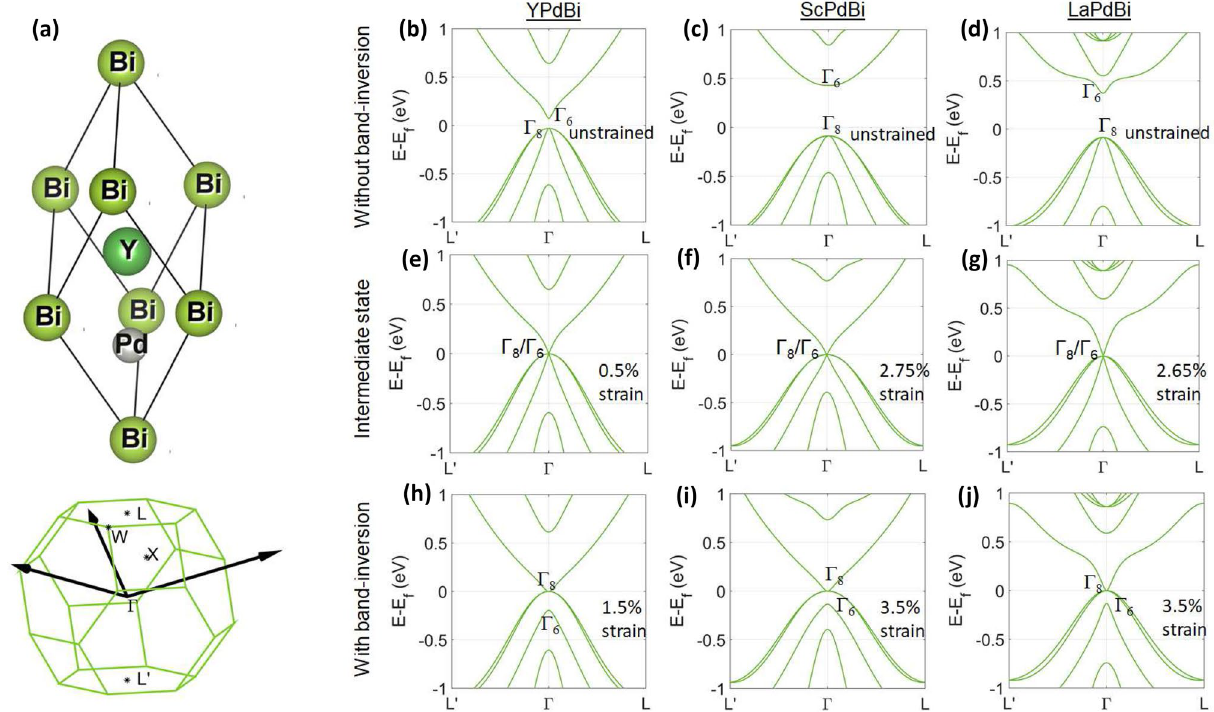
Figure 1. ( a ) Primitive unit cell of YPdBi and corresponding BZ with high-symmetry points and reciprocal vectors. All the materials considered in the present work has the same unit cell structure. ( b – j ) Band structure in YPdBi, ScPdBi and LaPdBi as a function of uniform tensile strain. Similar data for LuPdBi, YPtBi and LuPtBi under compressive strain are presented in the supplemetary